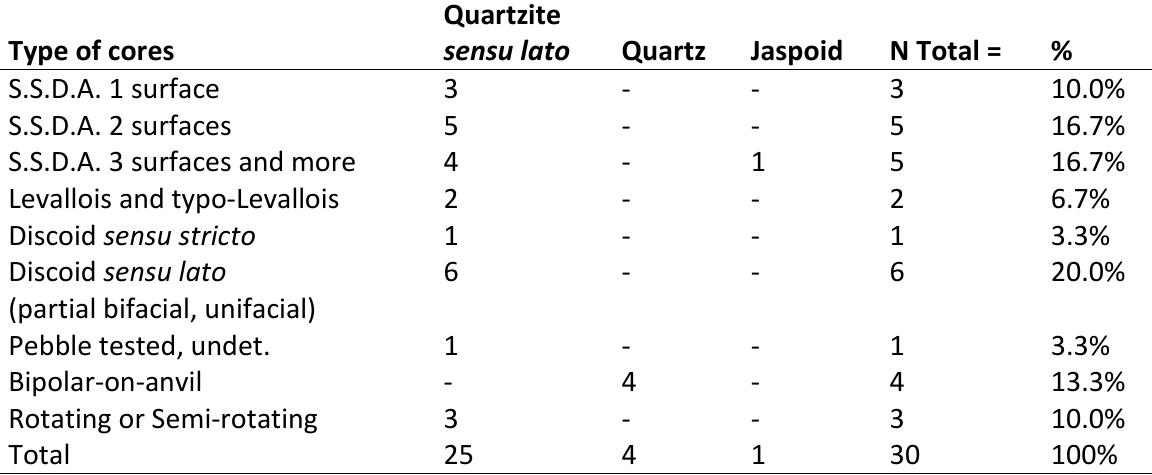
Table 5. Main types of cores identified at Les